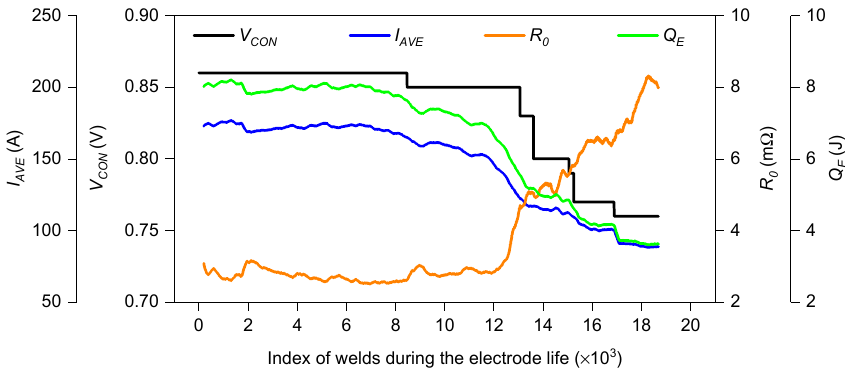
Figure 3. Curves of V CON , I AVE , R 0 and Q E during the electrode life.